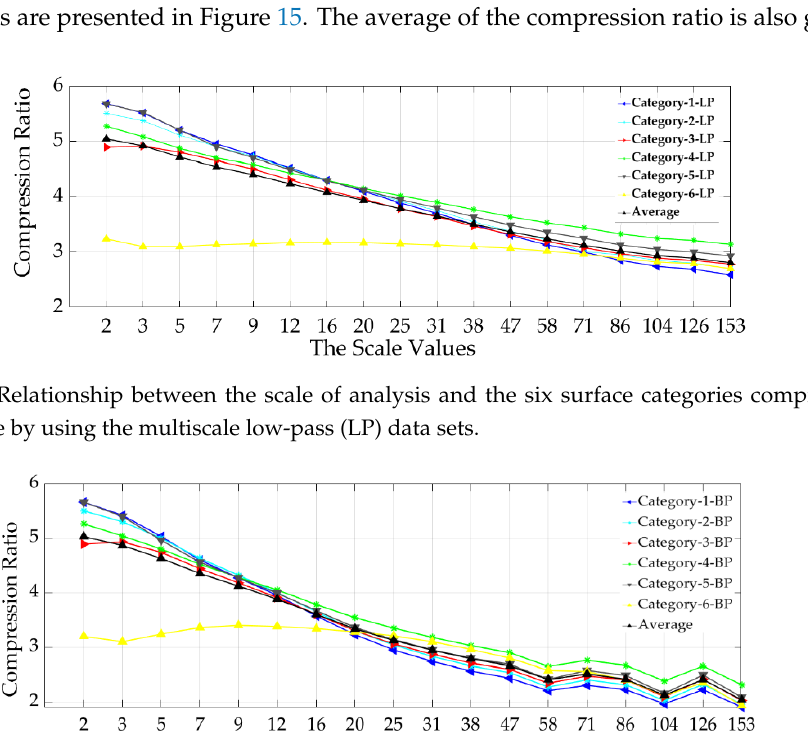
Figure 16. Relationship between the scale of analysis and the six surface categories’ compression performance by using the multiscale band-pass (BP) data sets.